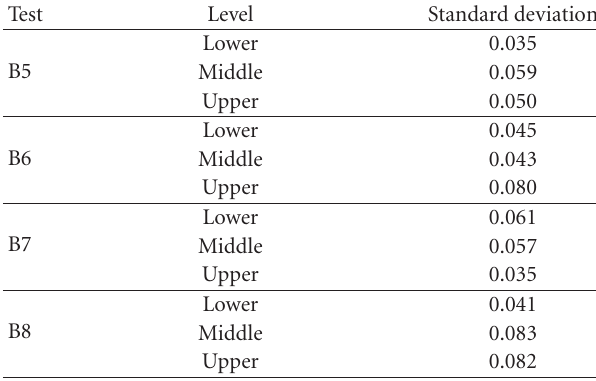
Table 9: Initial conditions for B7 transients.